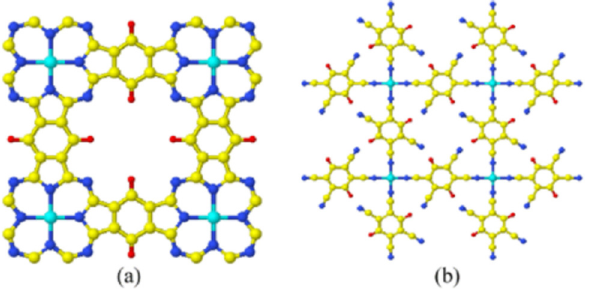
Figure 1: Structures of ( a ) 2DTM - Pc and the TM - TCNB, ( b ) metal - organic networks. The TM, N, C, and H atoms are highlighted in cyan, blue, yellow, and red,